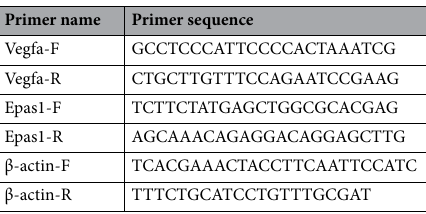
Table 1. Primer sequences.